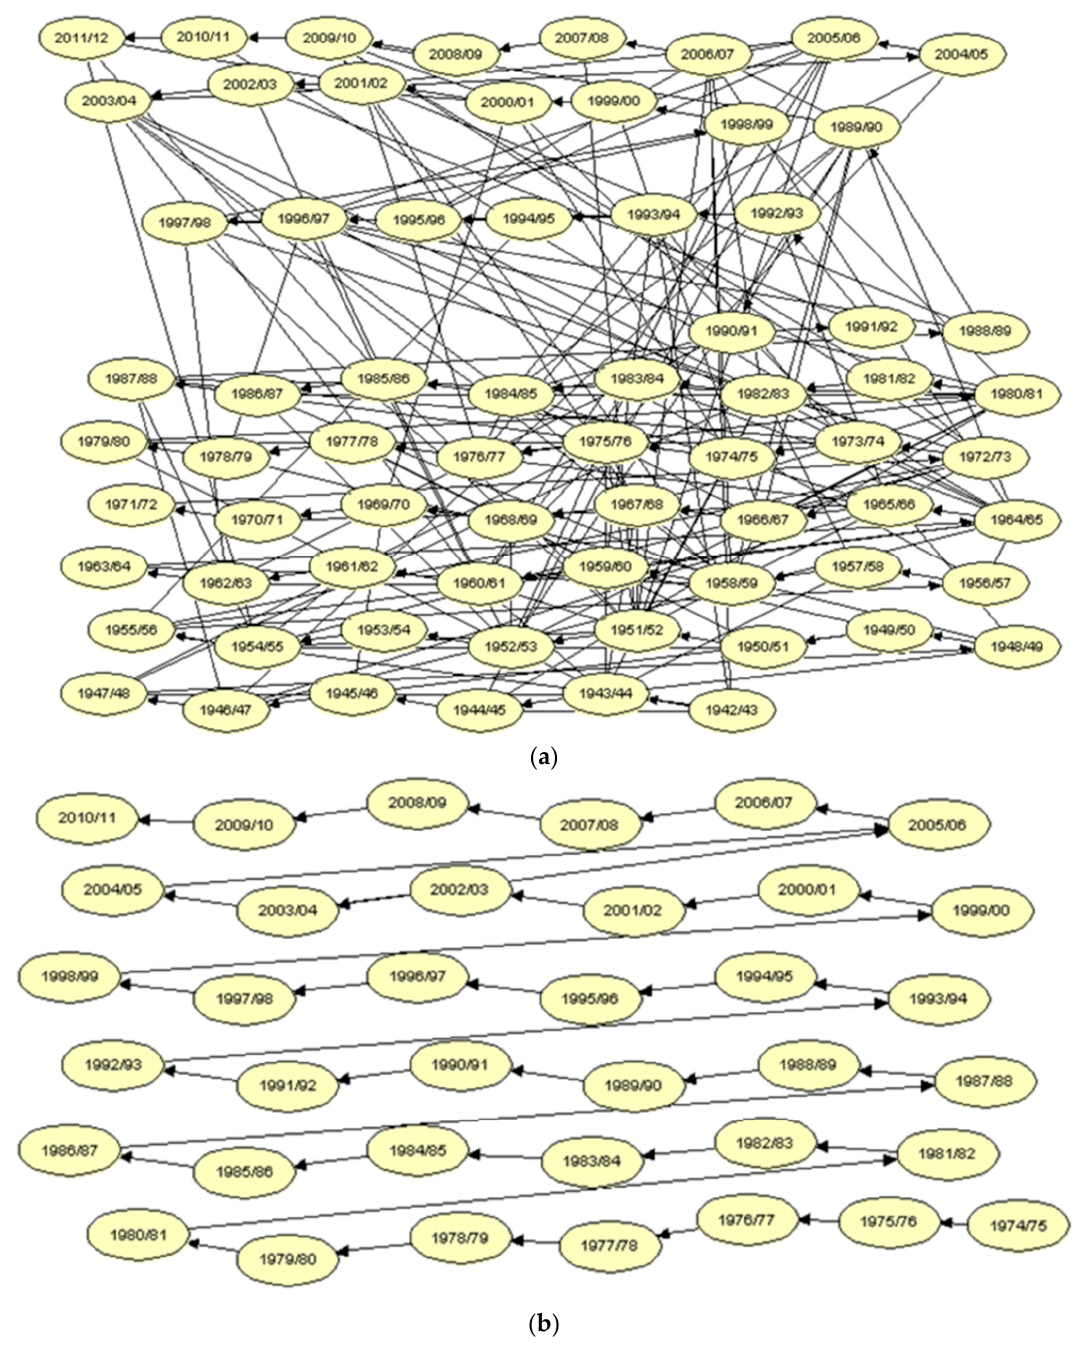
Figure 3. Bayesian Network Logic structure. ( a ) Adaja sub-basin; ( b ) Porma sub-basin. Note: Threshold level of independence ( p -value) 0.10 (up to 10% of relationships of independence between decision variables are shown).